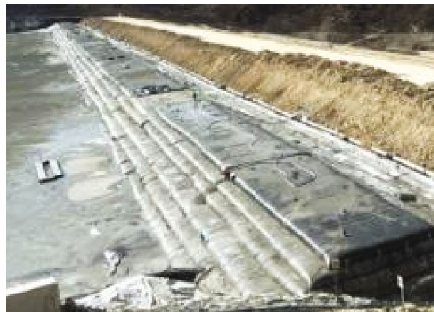
Figure 3: E ff ect of squeezing silt and replacement by soilbag.